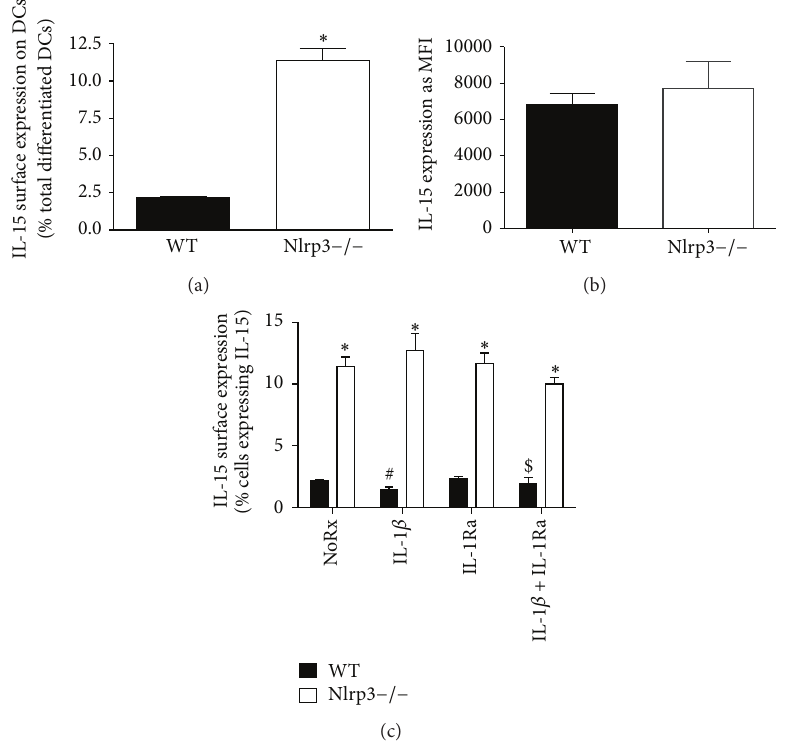
Figure 4: BM-derived DCs from Nlrp3 − / − mice exhibit increased frequency of IL-15 expression an effect that cannot be normalized by exogenous IL-1 𝛽 . (a) Flow cytometric analysis of IL-15 expression on the surface of WT and Nlrp3 − / − DCs differentiated from BM progenitor cellsfor10dayswithFlt3L(100ng/mL),expressedasapercentageofIL-15expressingcells(a)andMFIpercell(b).(c)Flowcytometricanalysis of IL-15 surface expression on WT and Nlrp3 − / − DCs differentiated from BM progenitor cells for 10 days with Flt3L (100ng/mL) and treated with IL-1 𝛽 (100ng/mL) and/or recombinant IL-1 receptor antagonist (IL-1Ra; 100 𝜇 g/mL) for 12 hours. ∗ denotes 𝑝 < 0.05 compared to WT mice; # denotes 𝑝 < 0.05 compared to WT, NoRx; $ denotes 𝑝 < 0.05 compared to WT-IL-1 𝛽 ; 𝑛 = 5